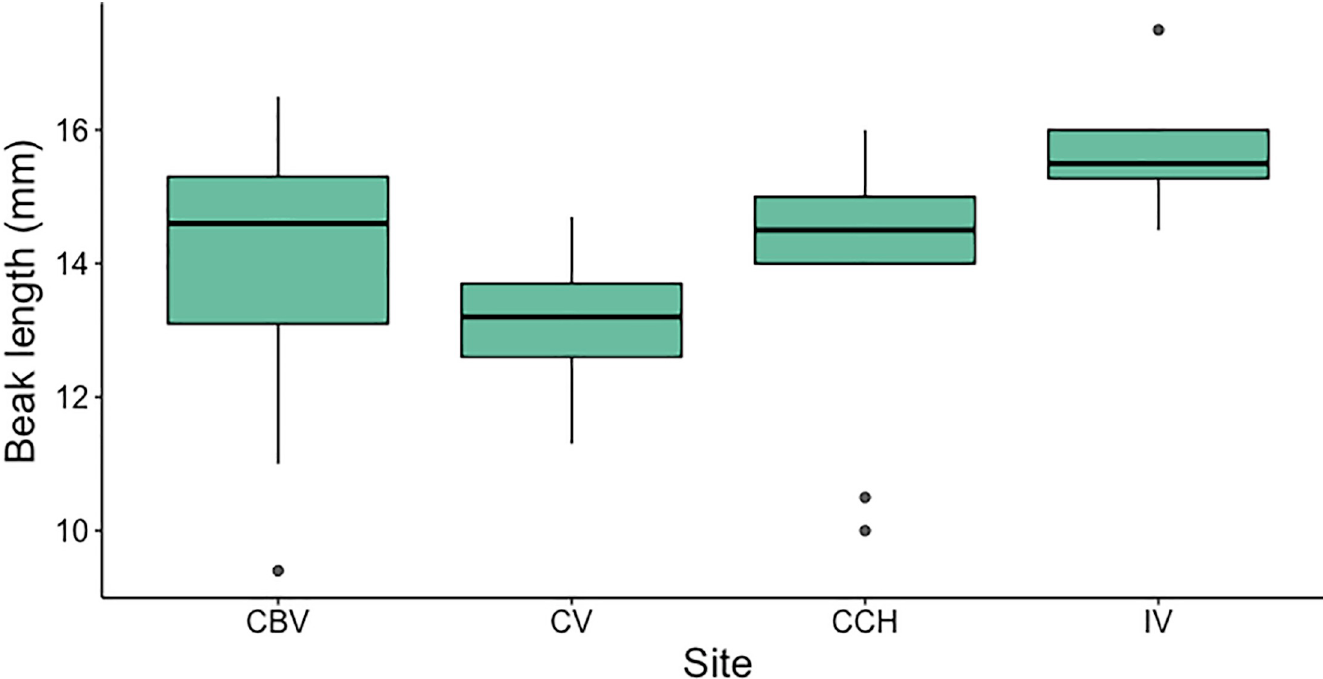
Fig 5. Bill length of timberline wrens from four populations in Costa Rica: CBV = Cerro Buena Vista, CV = Cerro Vueltas, CCH = Cerro Chirripo´, IV = Irazu´